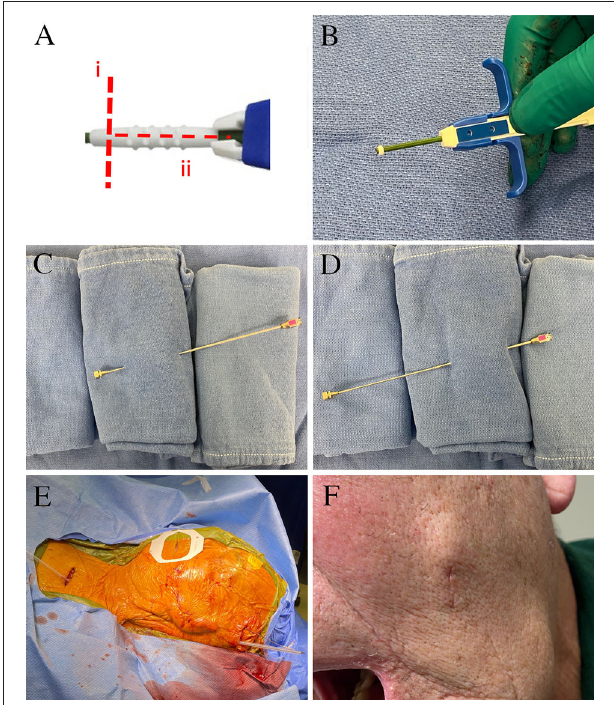
FIGURE 2 | Surgical images for permanent electrode placement. (A) The manufacturer-supplied anchor is modified by (i) a circumferential cut to create a 2-mm ring at the end closest to deployment, and (ii) a longitudinal cut that allows the remaining anchor to be removed. (B) The injectable anchor is modified using a scalpel to leave a 2-mm ring at the tip. The remaining anchor is opened longitudinally and removed. This is implanted over the lead in a 3-mm buccal incision. The lead was tunneled from the buccal incision to the temporal region using a reverse-tunneled Tuohy needle: (C) the stylet is passed from the buccal incision to the temporal incision, (D) the hollow Tuohy needle is then inserted over the tip of the stylet at the temporal incision, and tunneled back to the buccal incision. (E) The lead was then tunneled over the pinna and to the subclavicular generator incision. (F) The left buccal incision healed well without significant cosmetic concern.